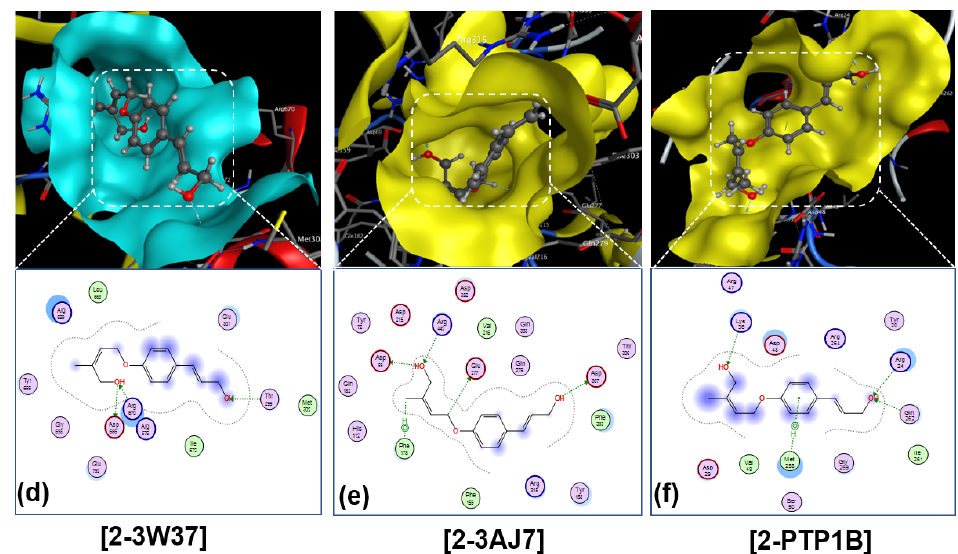
Figure 8. Visual presentation and in-pose interaction map of ligand-3W37, ligand-3AJ7, and ligand-PTP1B inhibitory